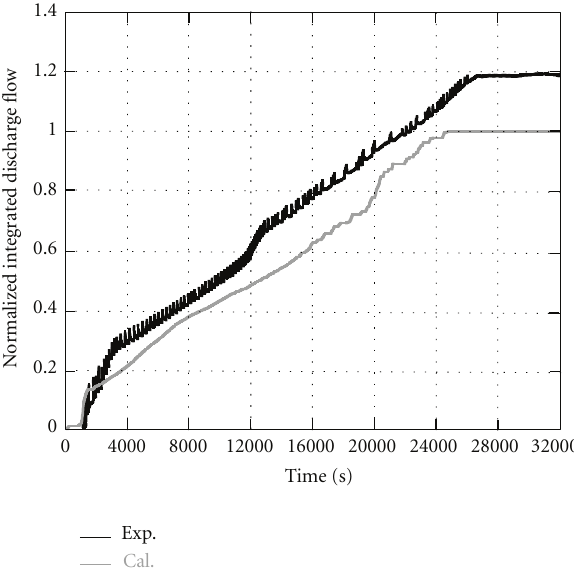
Figure 11: LSTF and RELAP5 results for integrated discharge flow through PORV.